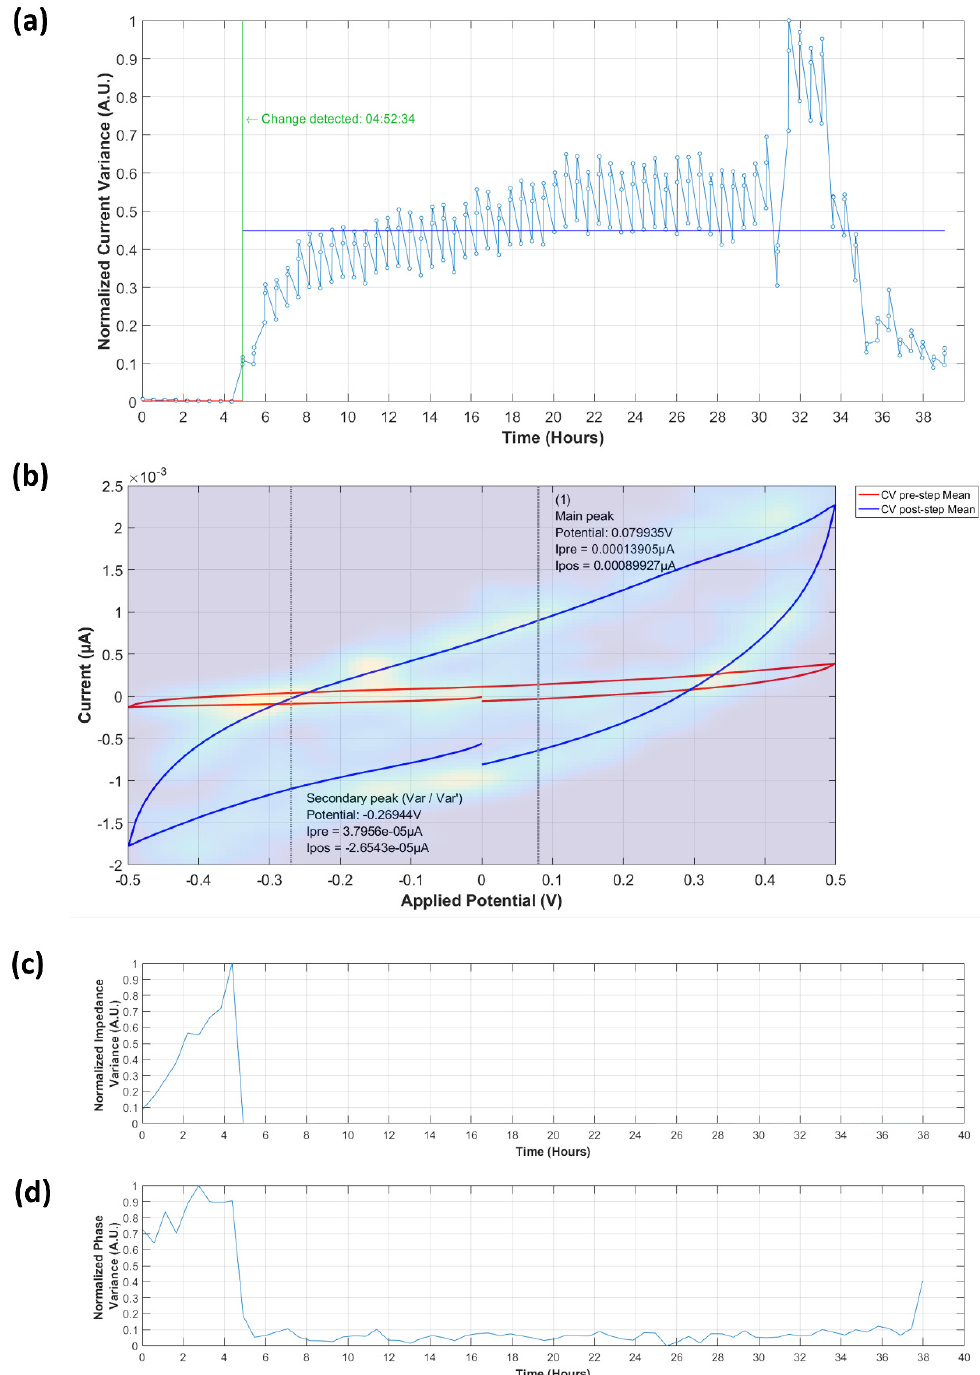
Figure A7. Recorded electrochemical response of a colonized microsystem for a ~38 h experiment. This experiment had a lower reported current density, and damage of the electrode can be observed at ~31 h. ( a ) Normalized current variance vs. time. Detected current peaks are indicated (peaks from variance to its first derivative ratio are indicated as Var/Var’, peaks from first derivative to second derivative ratio are indicated as Var’/Var’’. The current values at each peak are indicated for the mean before colonization event as I pre and for the mean after colonization event as I pos ). Note the characteristical step shape. ( b ) Recorded CV with calculated peaks and heatmap of detected peaks, where yellow represents a high concentration, and dark blue no peak. Note that the anodic peak is low; this can be a result of high resistance due to the electrode wearing off as a result of extended use. ( c ) Normalized impedance variance vs. time. ( d ) Normalized phase variance vs. time.